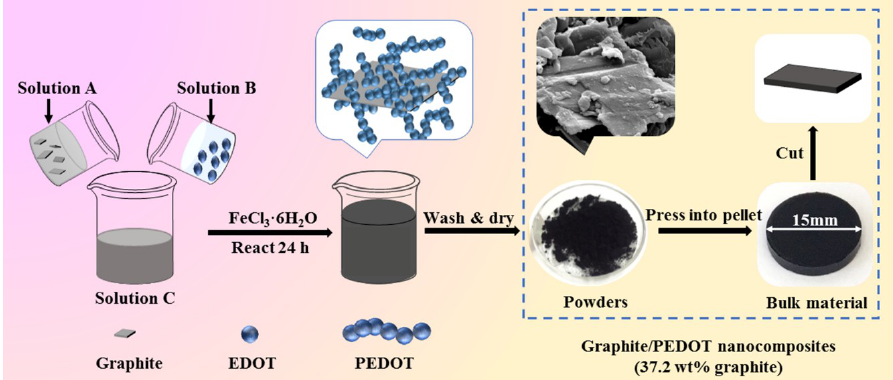
Figure 1. Schematic of the fabrication process of the graphite/poly(3,4-ethyenedioxythiophene) (PEDOT) nanocomposites and pellets.